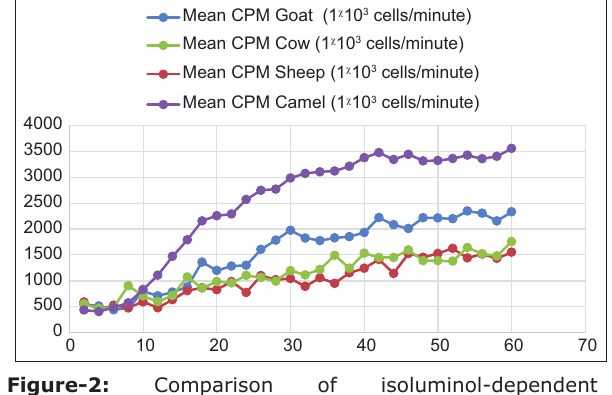
Figure-2: Comparison of isoluminol-dependent chemiluminescence of peripheral blood leukocytes from camels, goats, sheep, and cows.